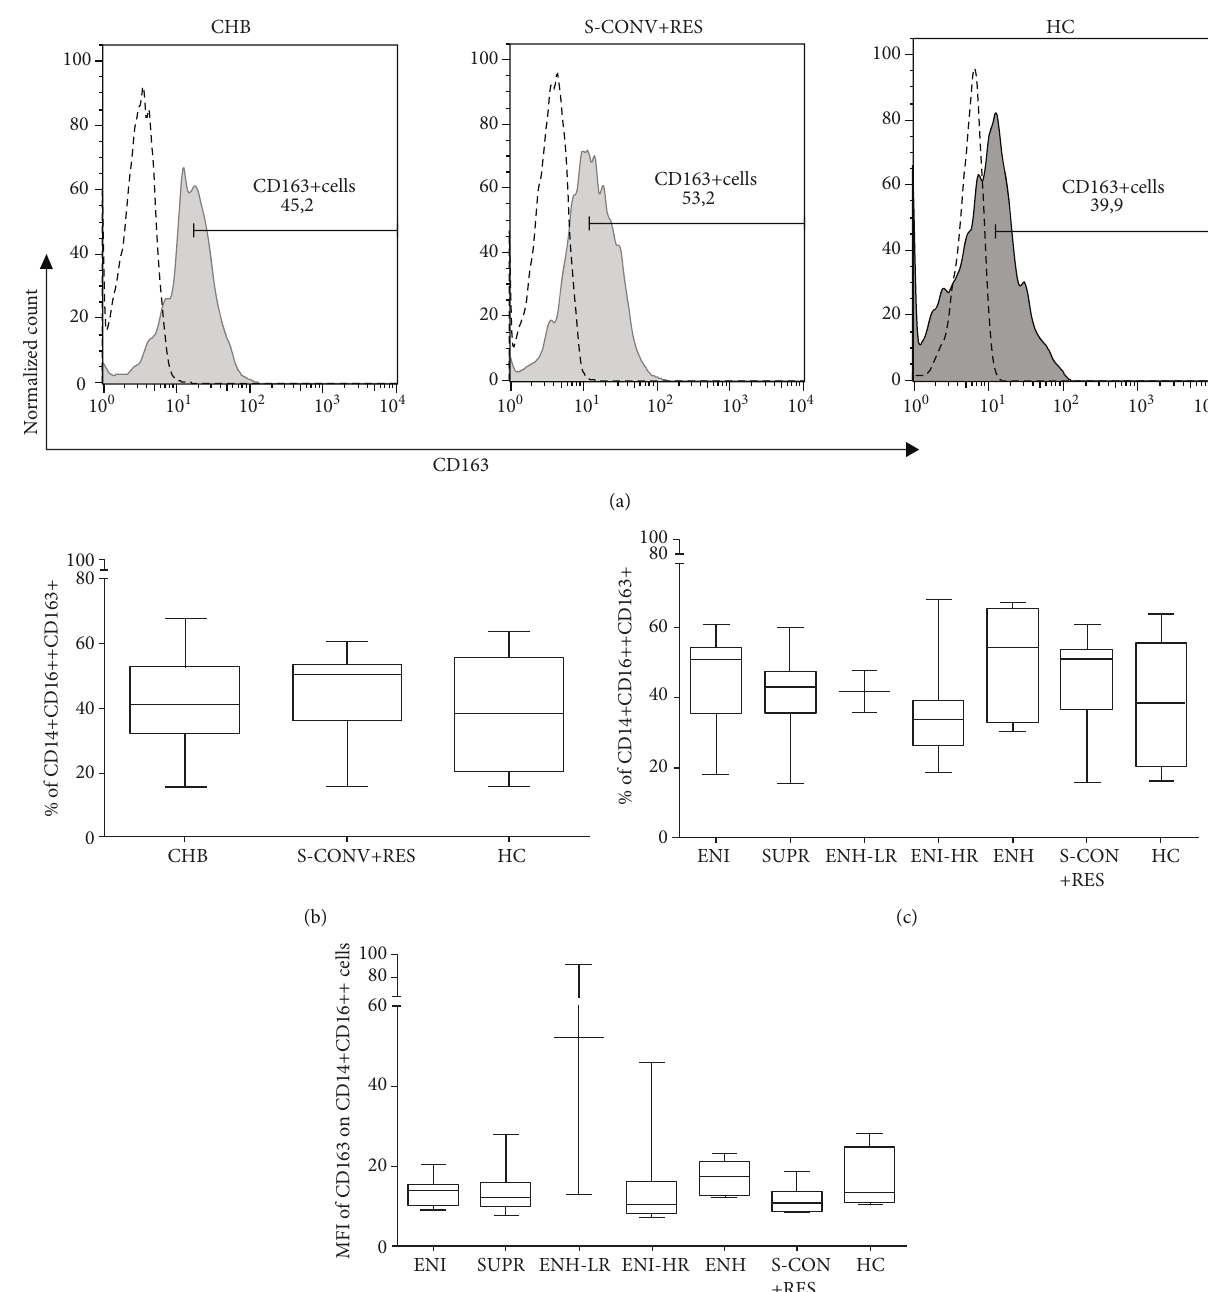
Figure 4: Frequency and expression of CD163 within nonclassical monocytes. (a) Representative histograms showing CD163 expression in CHB, S-CONV+RES, and HC groups (solid lines), with adequate FMO controls (dashed lines). (b) CD163 expression on nonclassical monocytes in CHB, S-CONV+RES, and HC groups. (c, d) Comparative analysis of CD163 expression on nonclassical monocytes with reference to the phase of CHB infection. Data presented as median values with 25 th and 75 th percentile and minimum-maximum